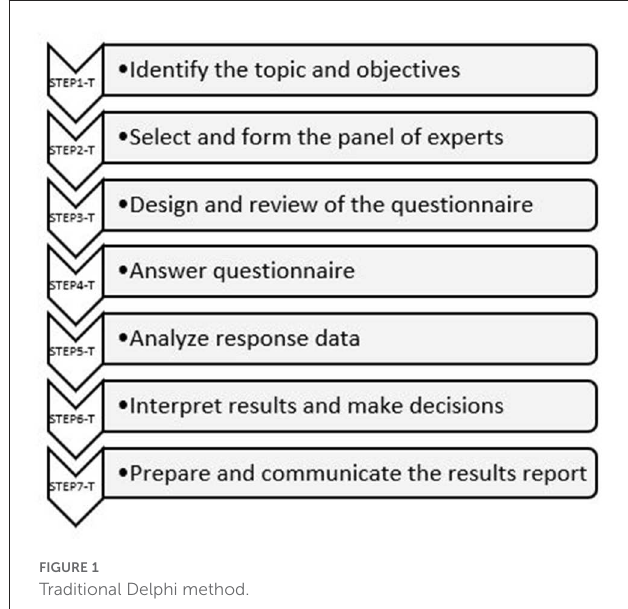
FIGURE1 Traditional Delphi